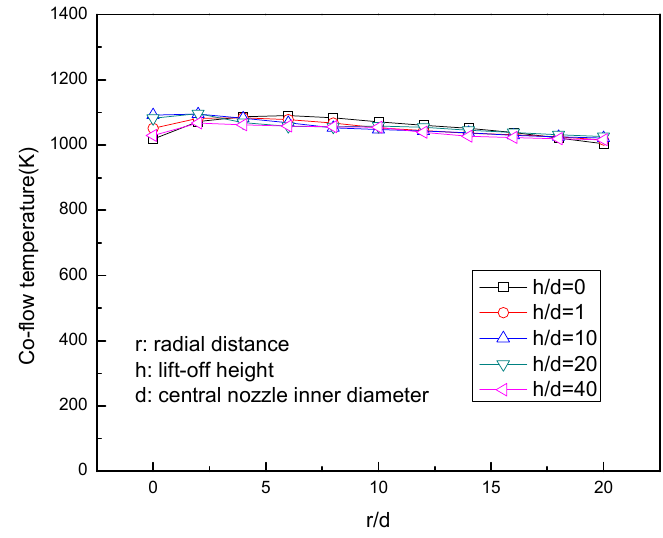
Figure 3. Distributions of co-flow temperature of the pressurized vitiated co-flow burner (PVCB).